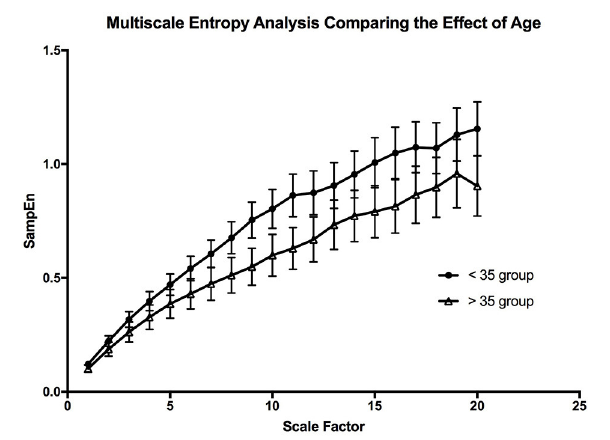
FIGURE 7 | The graph is depicting the effect of aging on the complexity of the oxygen saturation variability. The error bars are the standard error of the mean at each scale, and each point is the mean value at that scale from all the participants in the age